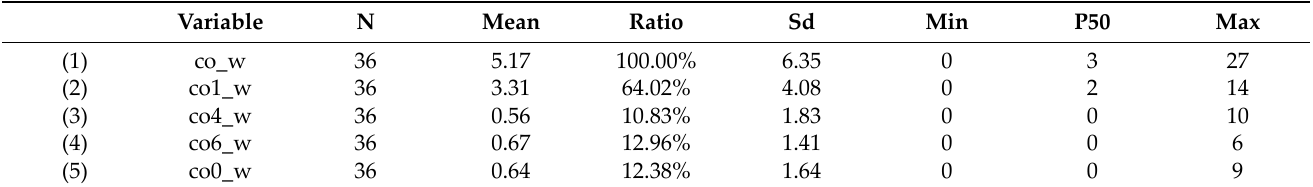
Table 7. Results the analysis of the level‑2 community subdimension on social media.